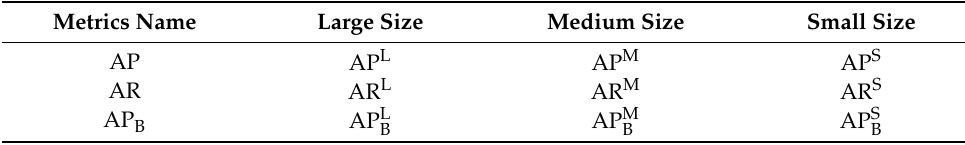
Table 2. The definition of AP, AR and AP B at different